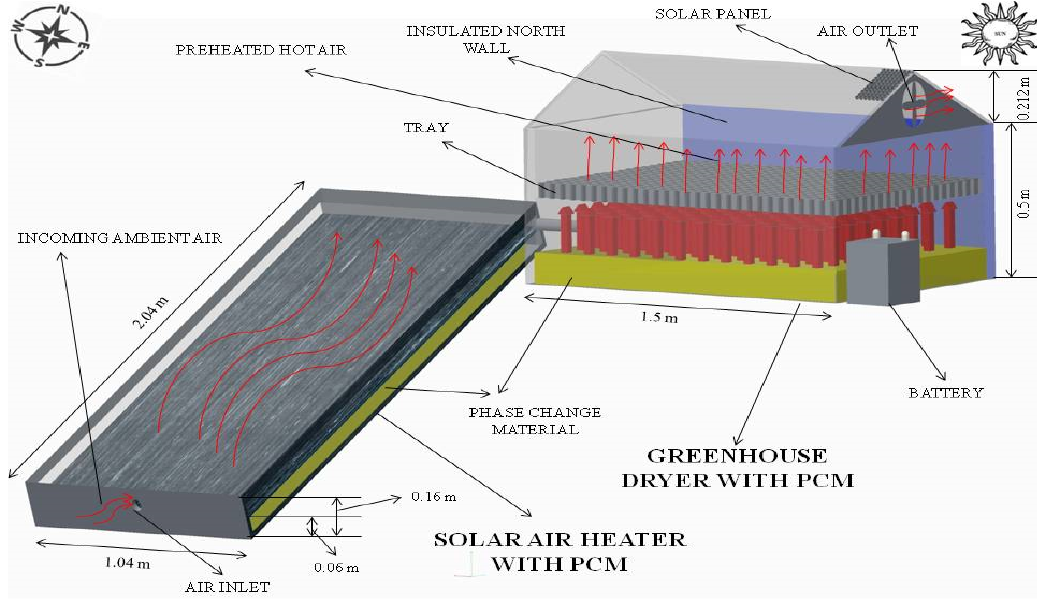
Figure 7. Hybrid greenhouse dryer.